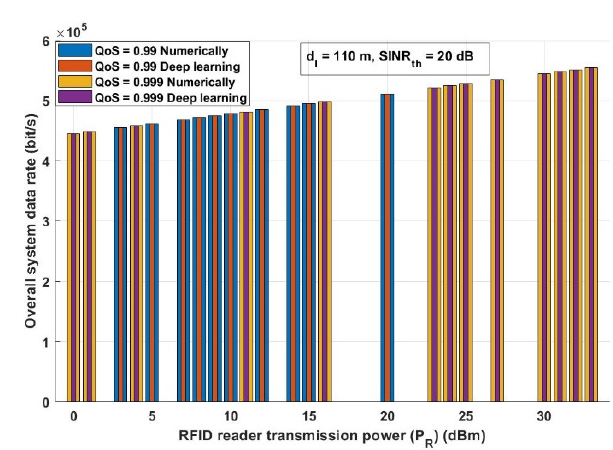
Figure 10. RFID reader transmission power ( P R ) (dBm) versus the required distance between an RFID reader and BS (m).